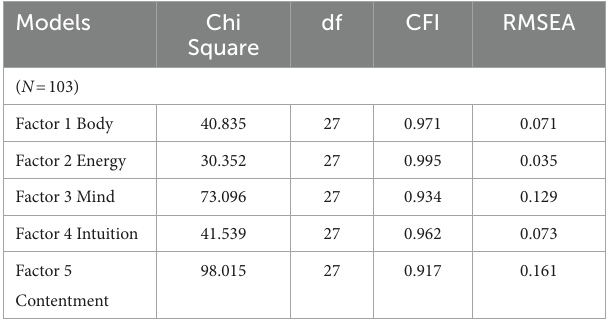
TABLE 3 Confirmatory factor analysis